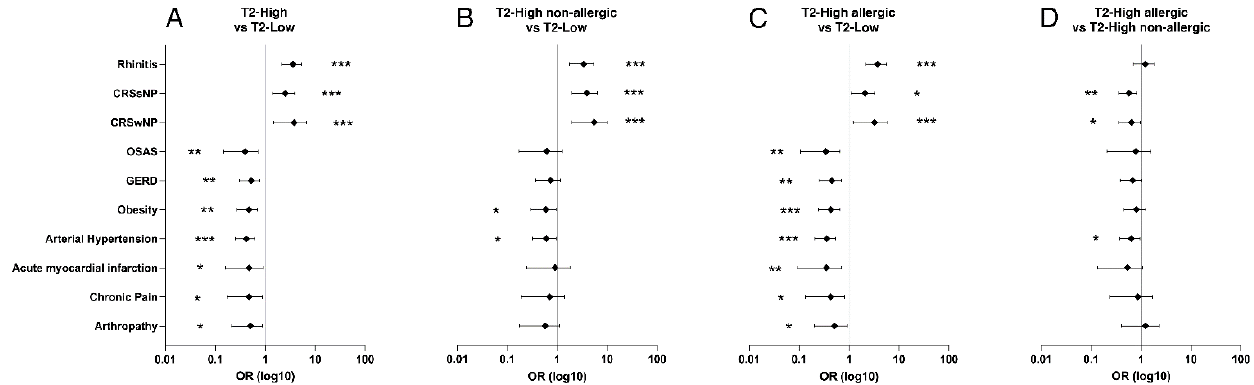
Figure 4. Forest plots of Odds Ratios ± 95% CI concerning comorbidity prevalence with significant differences between phenotypes at univariate analysis. Type 2 low is considered the reference in panels ( A – C ); Type 2 high non-allergic is considered the reference in panel ( D ). * = p < 0.05; ** = p < 0.01; *** = p < 0.001.